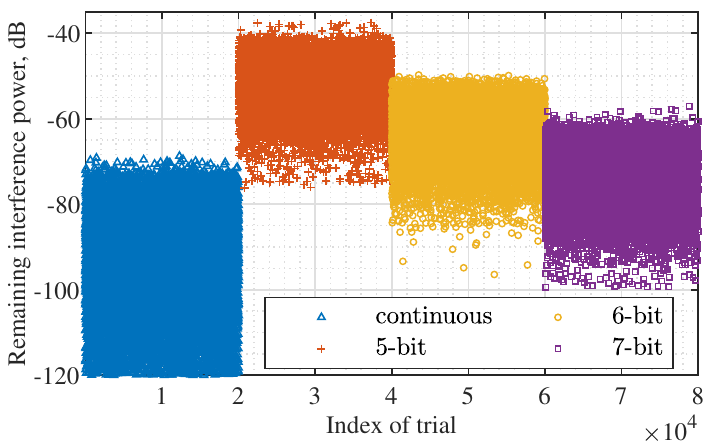
Figure 11. Illustrating the impact of the quantization bit of phase shifters in subarrays on interfer- ence